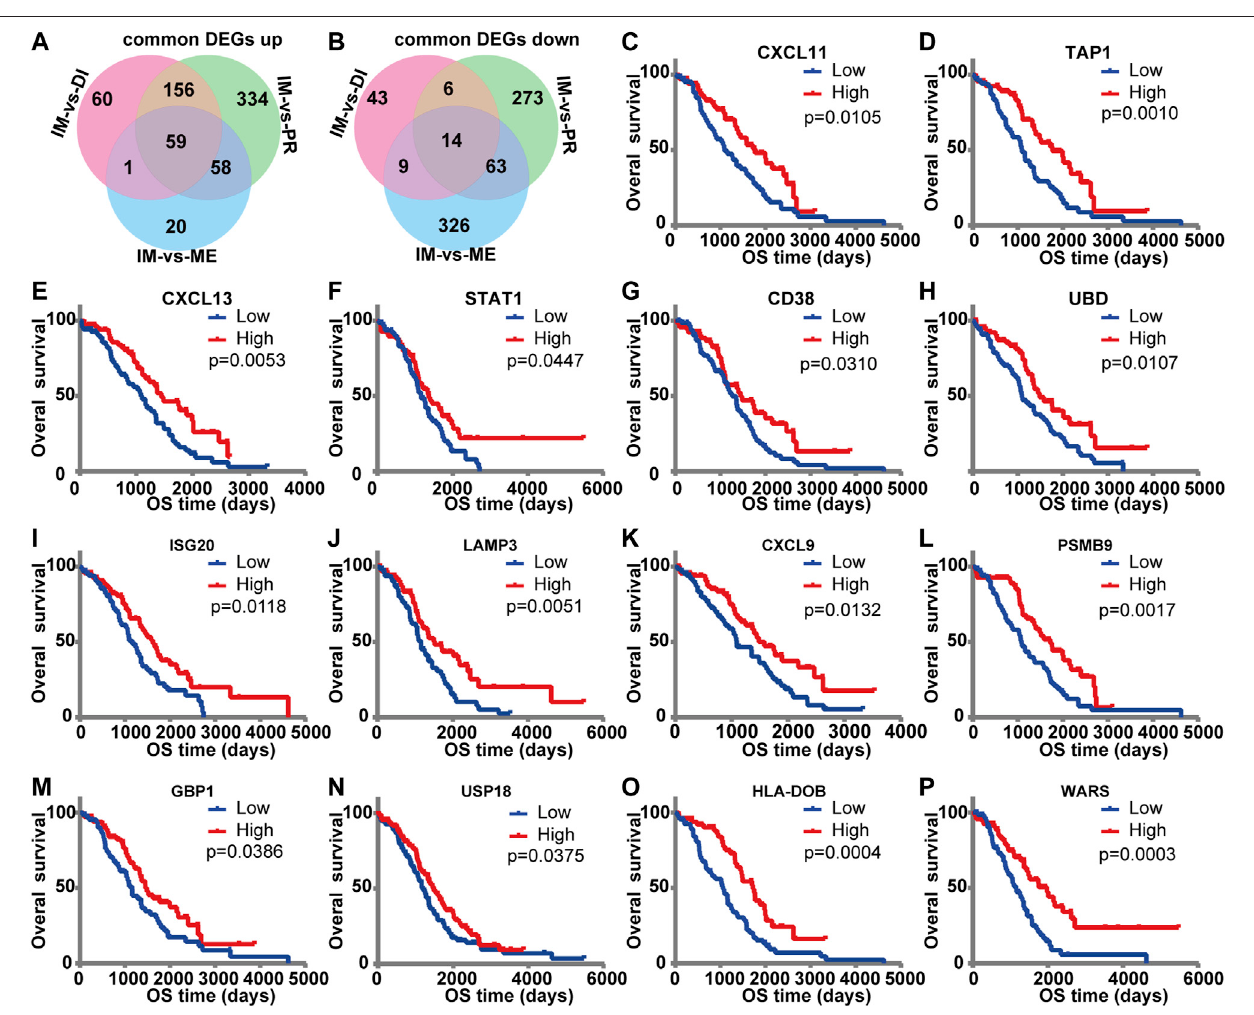
FIGURE4 | The prognostic valueofDEGs for overall survival inthe TCGA database. Venn diagram ofcommon DEGs. Itshowed the common upregulated (A) and down-regulated (B) differential genes in the three comparison groups. (C – P) Kaplan-Meier survival curves were used to identify common differential genes with prognosticsigni fi cance.Thein fl uenceofhighandlowexpressionofeachDEGonoverallsurvivalwascompared.Theredlineindicatedhighexpression,andtheblueline indicated low expression. p < 0.05 was considered as